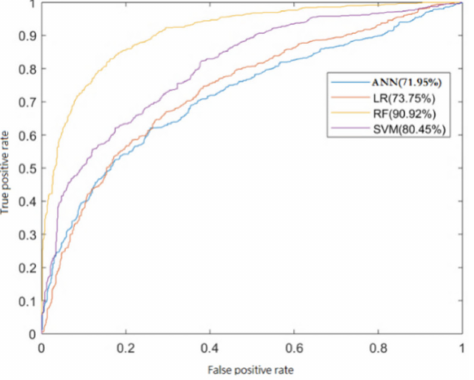
Figure 7. ROC and AUC: ANN, LR, RF, SVM.